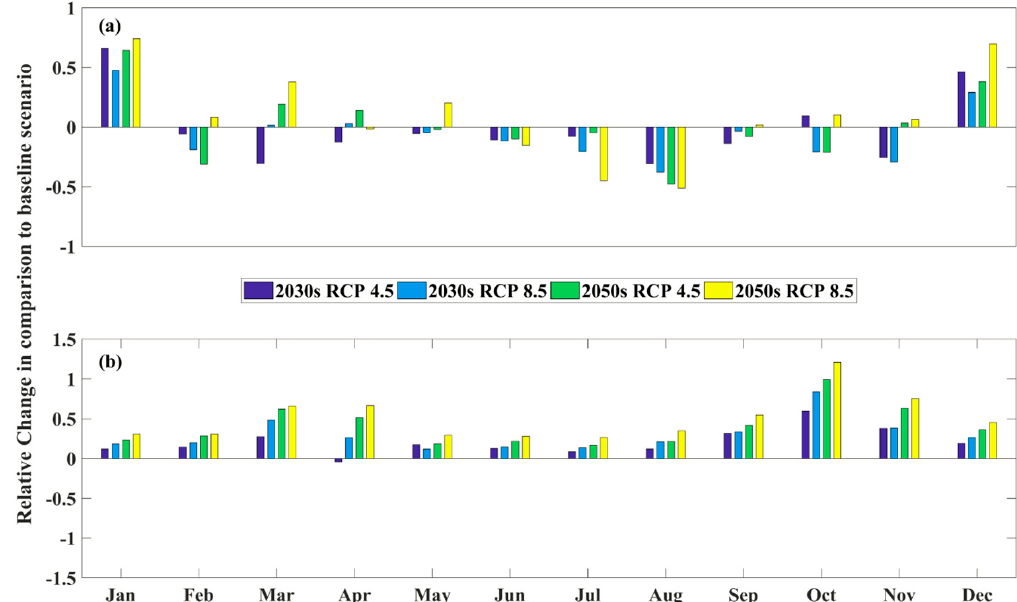
Figure 6. Projected relative changes in comparison to the baseline period for ( a ) precipitation and ( b ) average temperature under RCP 4.5 and RCP 8.5 for near (2030) and middle (2050) futures, averaged across the basin.